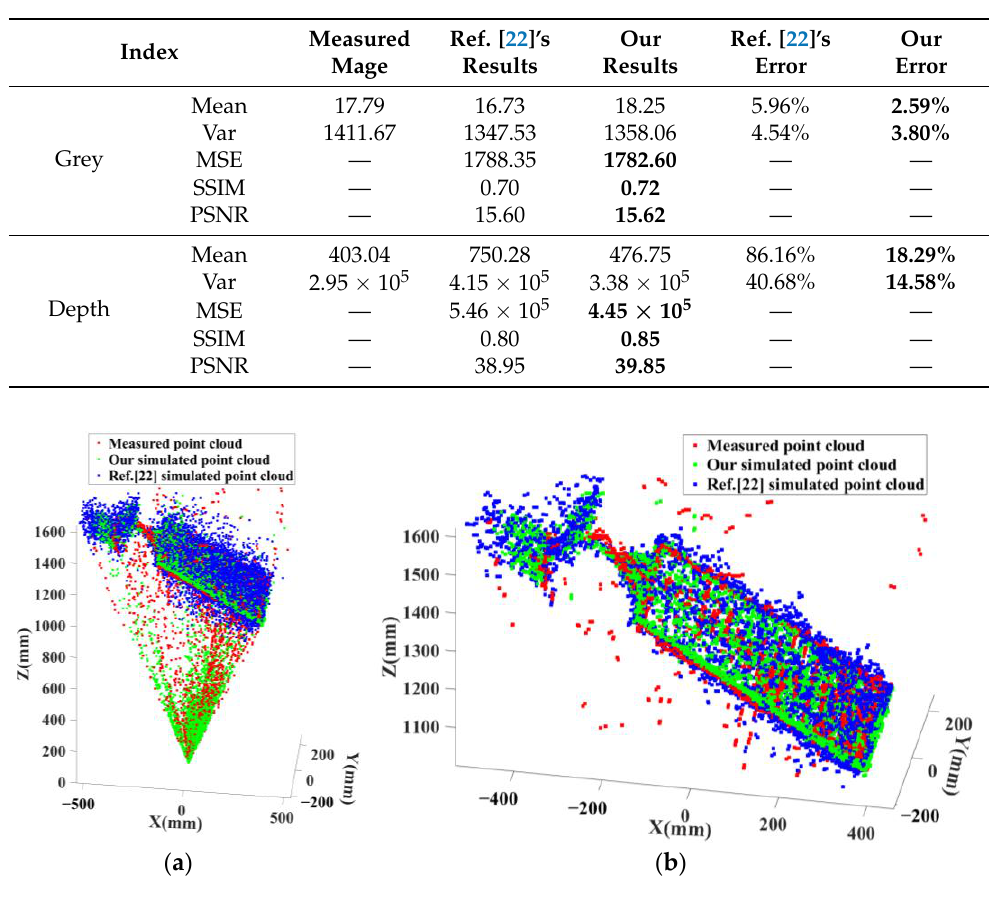
Figure 15. The simulated and measured point cloud. ( a ) Original simulated and measured point clouds; ( b ) simulation and measured point cloud after denoising. Table 5. Comparison of indexes between measured images and simulated images.